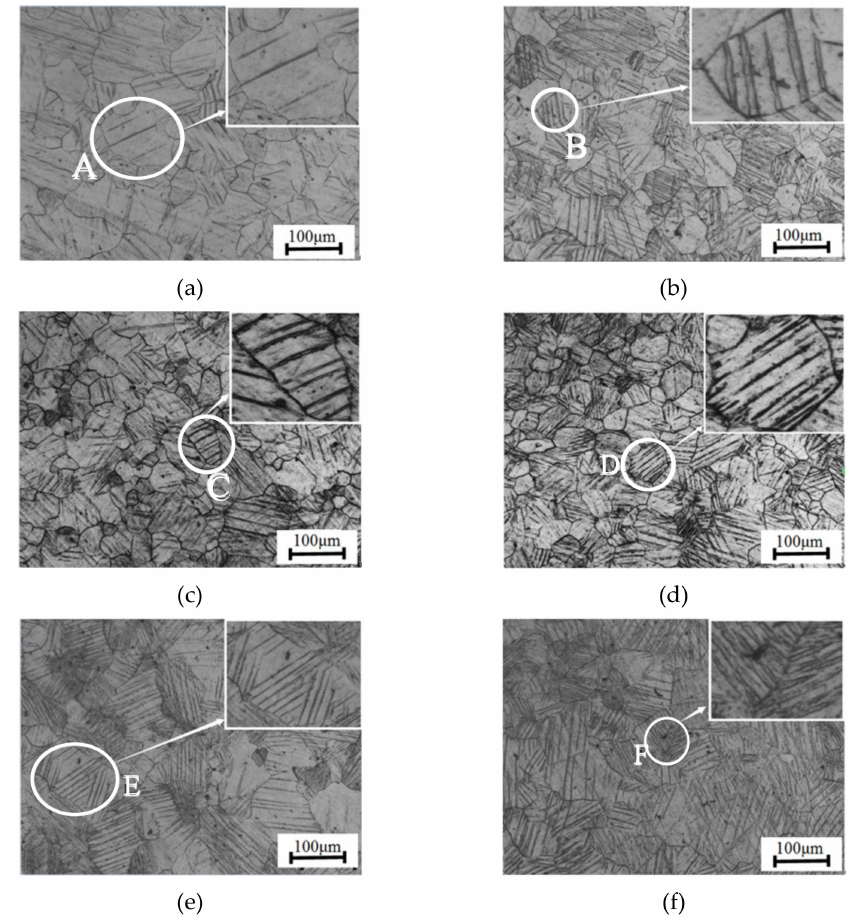
Figure 3. Metallographic microstructure at di ff erent strain amplitudes: ( a ) 0.3%; ( b ) 0.5%; ( c ) 0.8%; ( d ) 1.2%; ( e ) 1.5%; ( f )